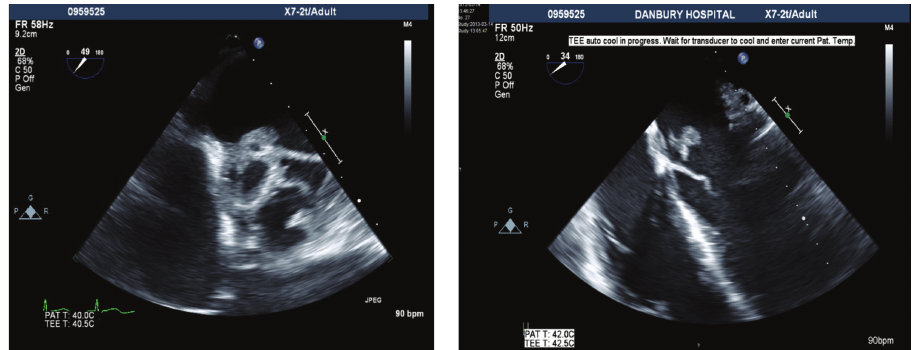
Figure 3: Transesophageal echocardiogram. Mass seen on anterior leaflet measuring 1.2 × 1.8cm with perforation of the leaflet. Bicuspid aortic valve with severe aortic regurgitation and abscess cavity and fistula extending from right coronary cusp to left